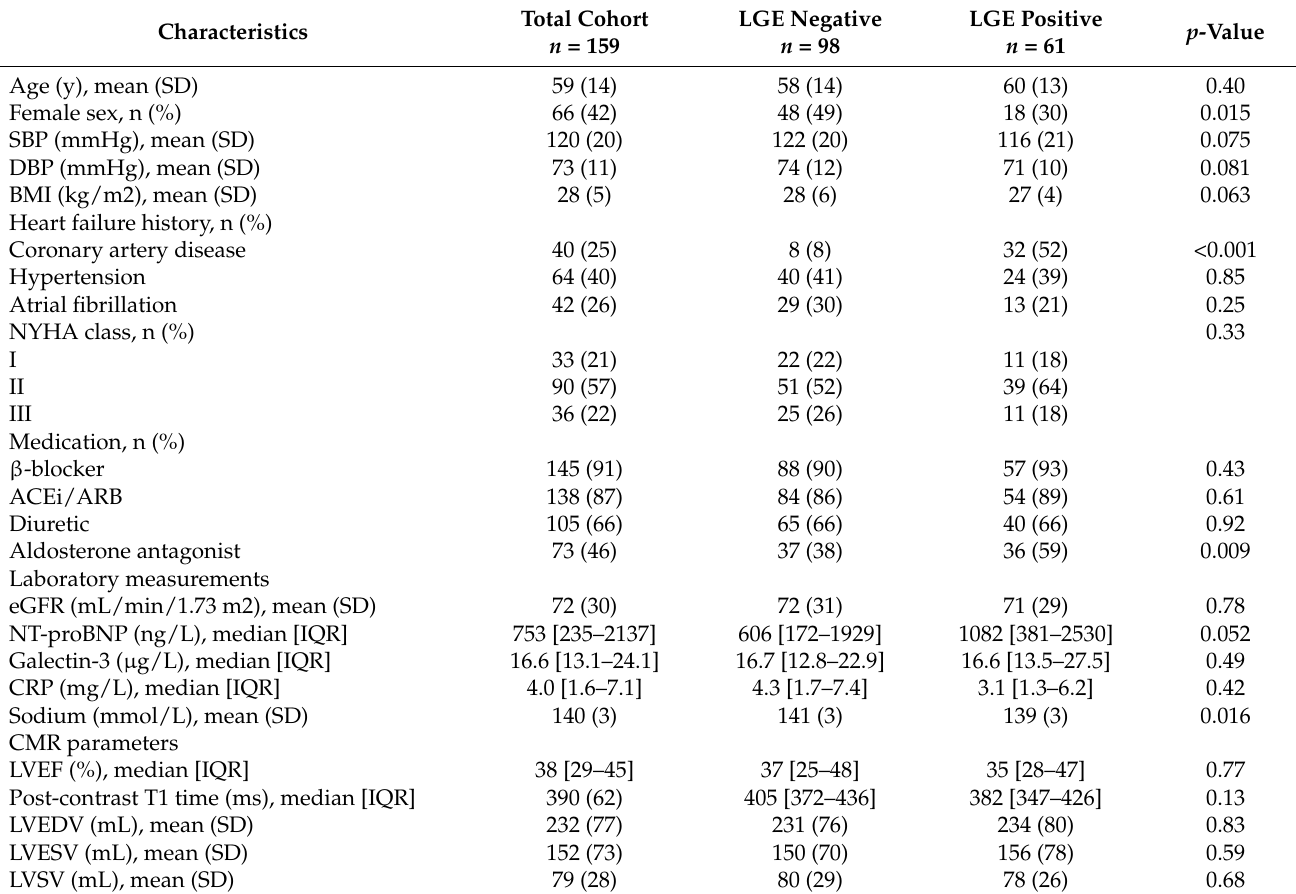
Table 1. Baseline characteristics of the total study cohort, divided by the presence of LGE.